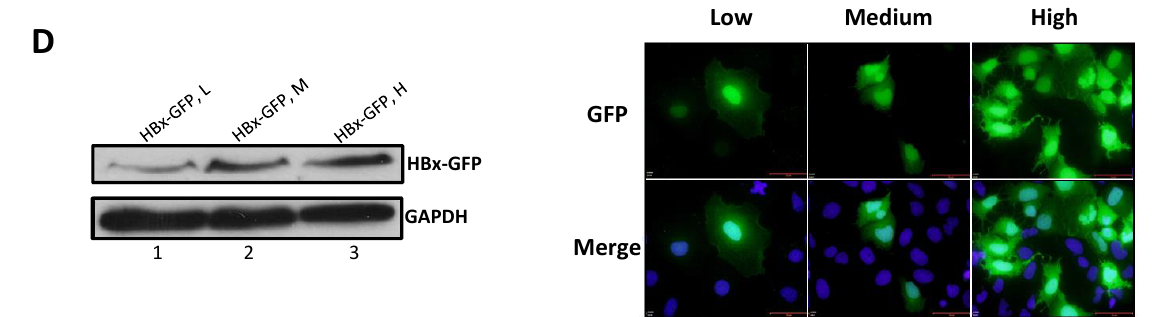
Figure 1. Organization domains of the HBV HBx protein, and expression of the wild-type and point mutant in cells. ( A ) Functional domains of the HBx protein, and point mutated residues. ( B ) Time-course expression of the tagged-HBx protein in human hepatoma cells. Left panel, HBx-GFP construct and right panel, 3xFLAG-HBx protein. ( C ) Expression of HBx point mutant constructs in human hepatoma cells. Left panel, WT HBx-GFP construct and right panel, 3xFLAG-HBx (WT) protein. ( D ) DNA concentration-dependent control expression of the HBx-GFP construct (left panel), and fluorescence of GFP protein in hepatoma cells (right panel). Bar for scale of 50 µ